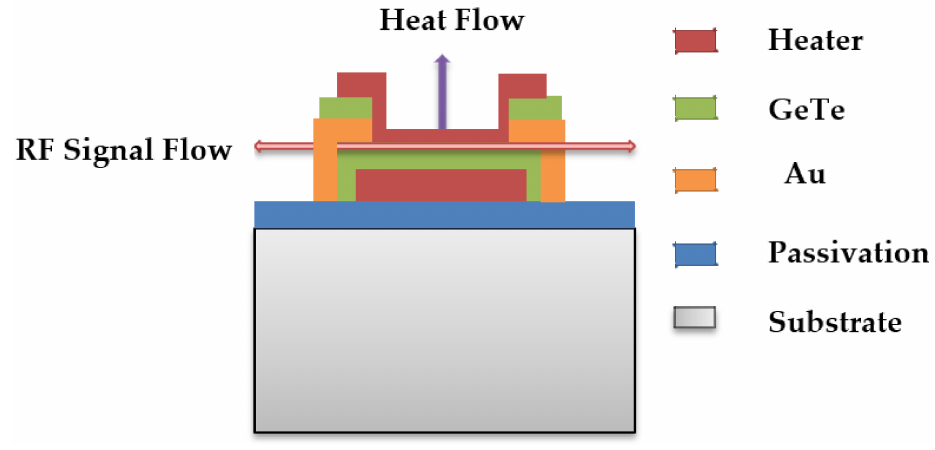
Figure 6. Device layout for a four terminal directly heated GeTe based RF